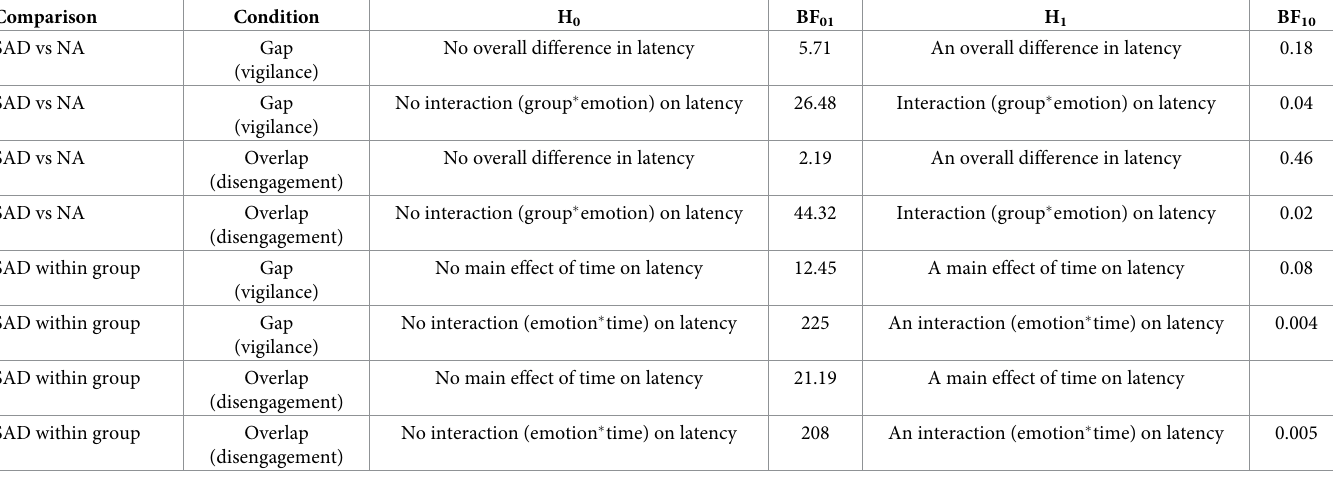
Table 3. Bayes factors indicating the relative likelihood that the observed data would occur under H 0 and H 1 .